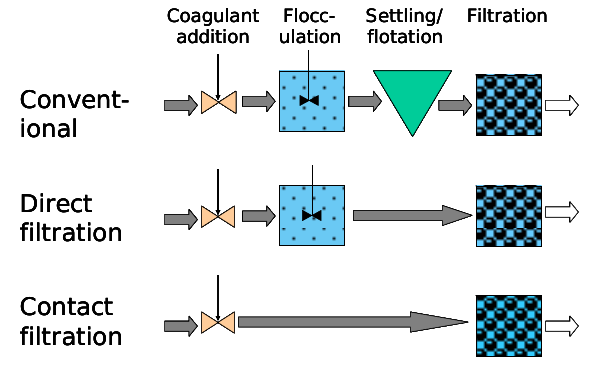
Figure 2. Coagulation / floc separation flow Fig. 2. Coagulation/floc separation flow schemes